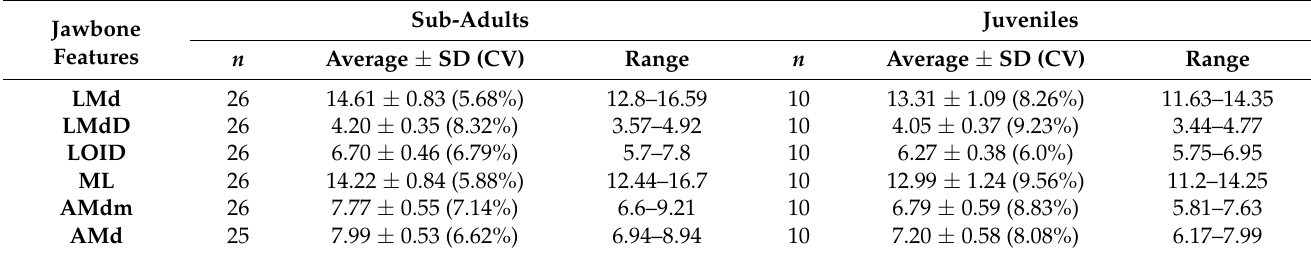
Table 8. Morphometric data for jaw-bone dimensions of sub-adult and juvenile Pannonian root vole. Jawbone